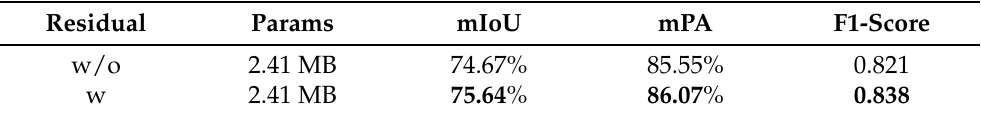
Table 4. Ablation study results for residual connection.